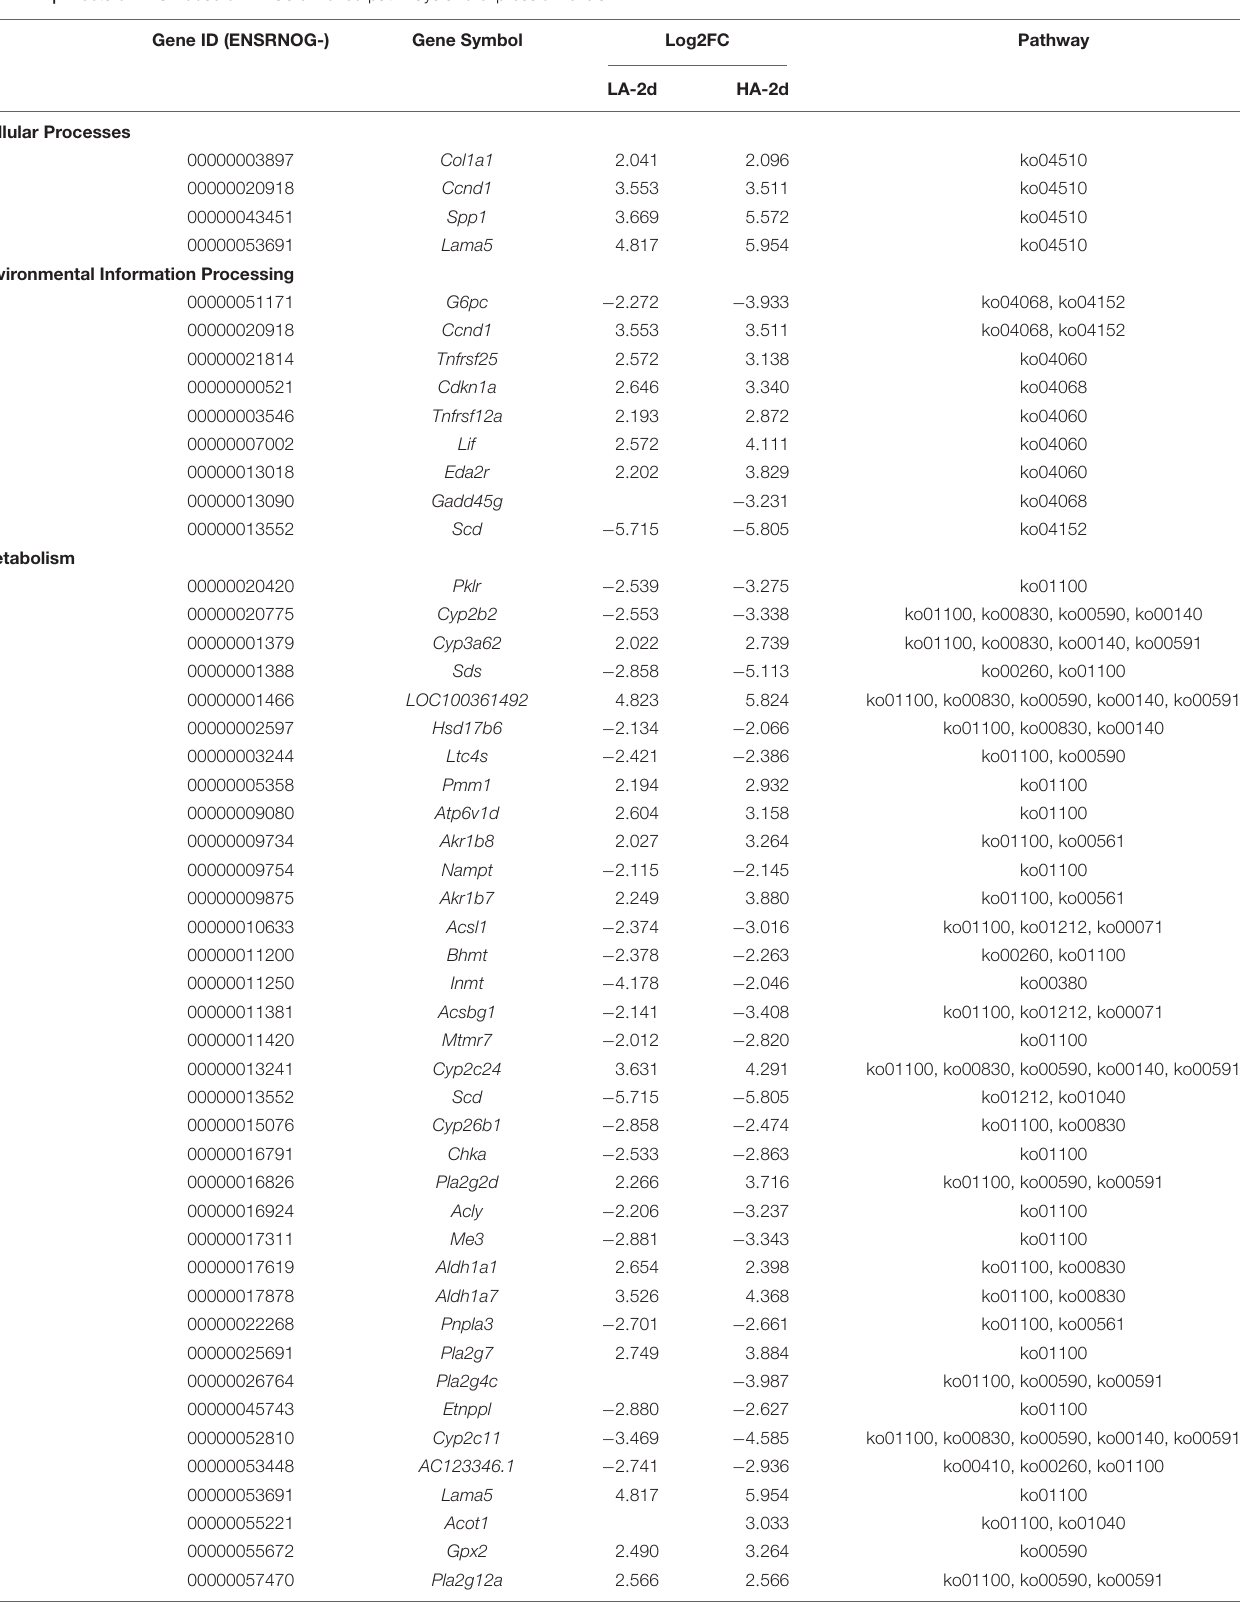
TABLE 4 | Effects of AESE dose on DEGs enriched pathways and expression